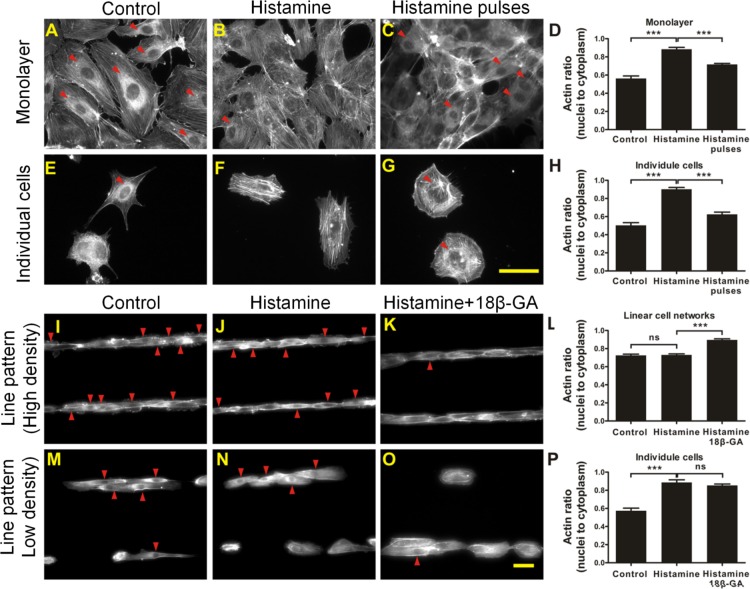
Actin cytoskeleton of cells in different configurations after histamine treatment.(A–C) Monolayers. (E–G) Individual cells. (I–K) Linear cell networks with high cell density. (M–O) Linear cell networks with low cell density. Cells were stained with Alexa Fluor® 555 Phalloidin for F-actin. Results are representative of 5 independent experiments. (D, H, L and P) Quantitative analysis of the actin ratio (nucleus to cytoplasm) in (D) monolayers, (H) individual cells, (L) linear cell networks, and (P) individual cells in linear pattern with low cell density (Bonferroni's multiple comparison test; ns, not significant; ***, P<0.001; n = 5). Red arrows indicate cells with actin ratio of nucleus to cytoplasm below 0.7. Scale bars, 50 μm.